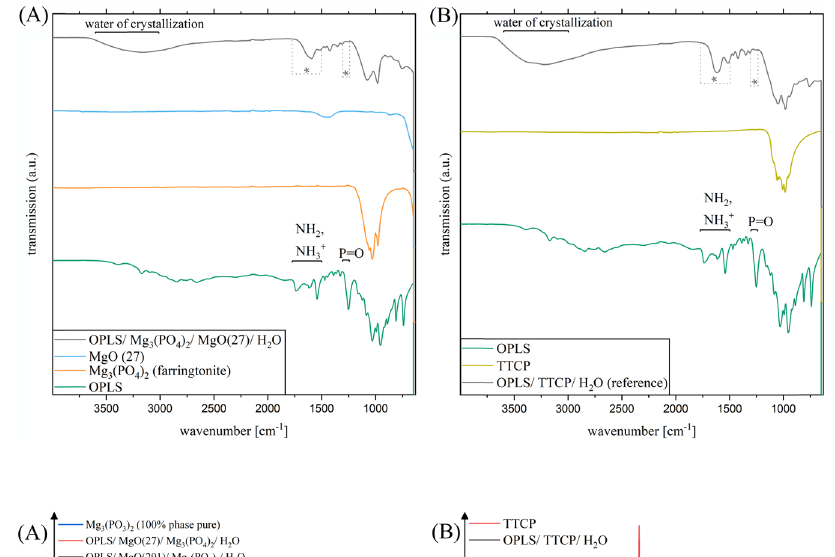
Fig. 5 Diffraction patterns of: ( A ): OPLS/ MgO(291)/ Mg 3 (PO 4 ) 2 / H 2 O (black), OPLS/ MgO(27)/ Mg 3 (PO 4 ) 2 / H 2 O (red) and farringtonite (blue) ( “ m ” : magnesium oxide). B OPLS/ TTCP/ H 2 O (grey) and TTCP (red). C Mg 3 (PO 4 ) 2 ∙ xH 2 O before (grey) and after heat treatment (red) ( “ pp ” : pyrophosphate; “ m ” : magnesium oxide) . D Mg 3 (PO 4 ) 2 ∙ xH 2 O (heat treated) before (blue) and after (grey) reaction with OPLS and H 2